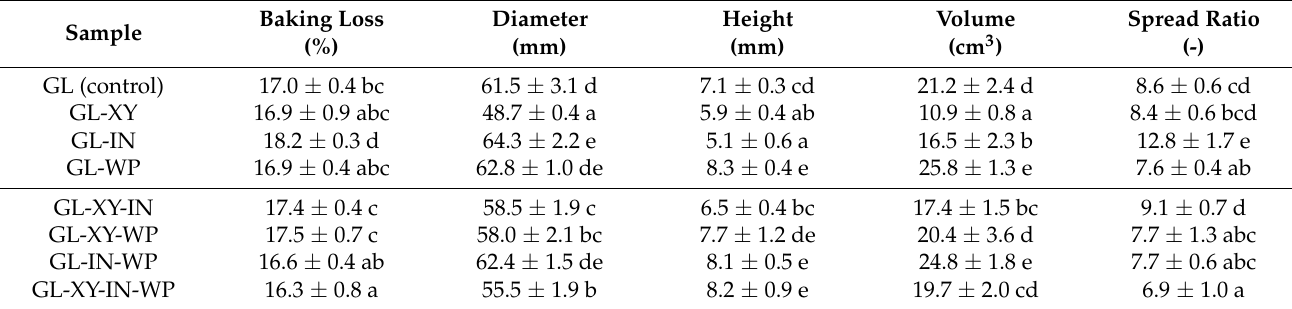
Table 2. Baking loss and geometry of green lentil